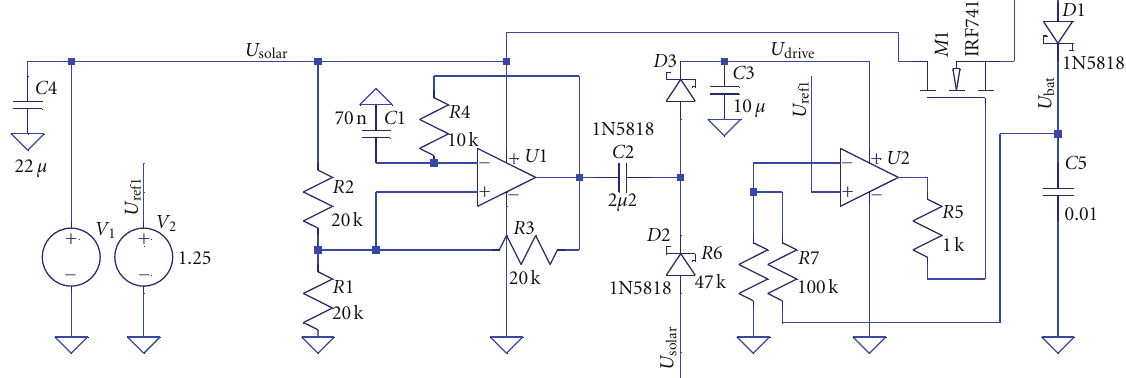
Figure 3: Scheme of charging circuit for Li-ION rechargeable